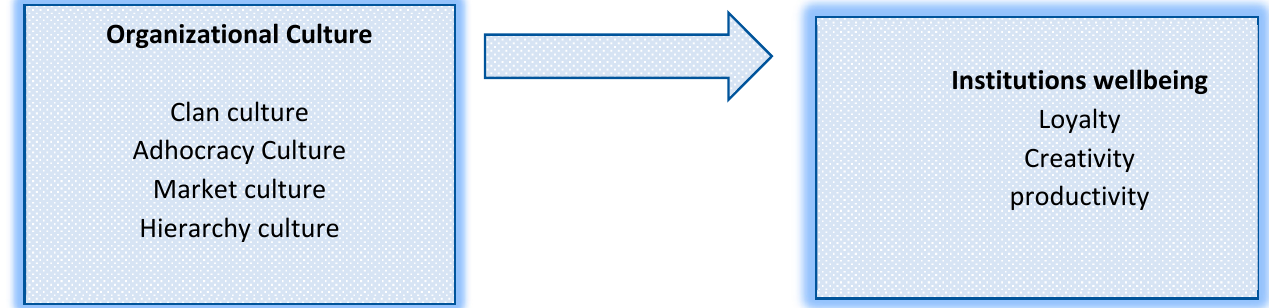
Figure 5. Conceptual framework. Figure created by the author.